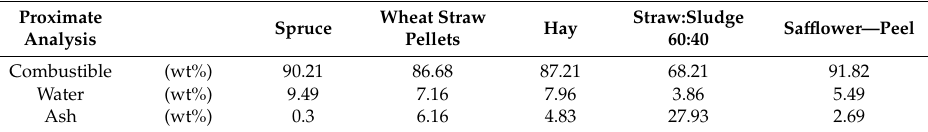
Table 3. Evaluation of the rough analysis of the selected samples.